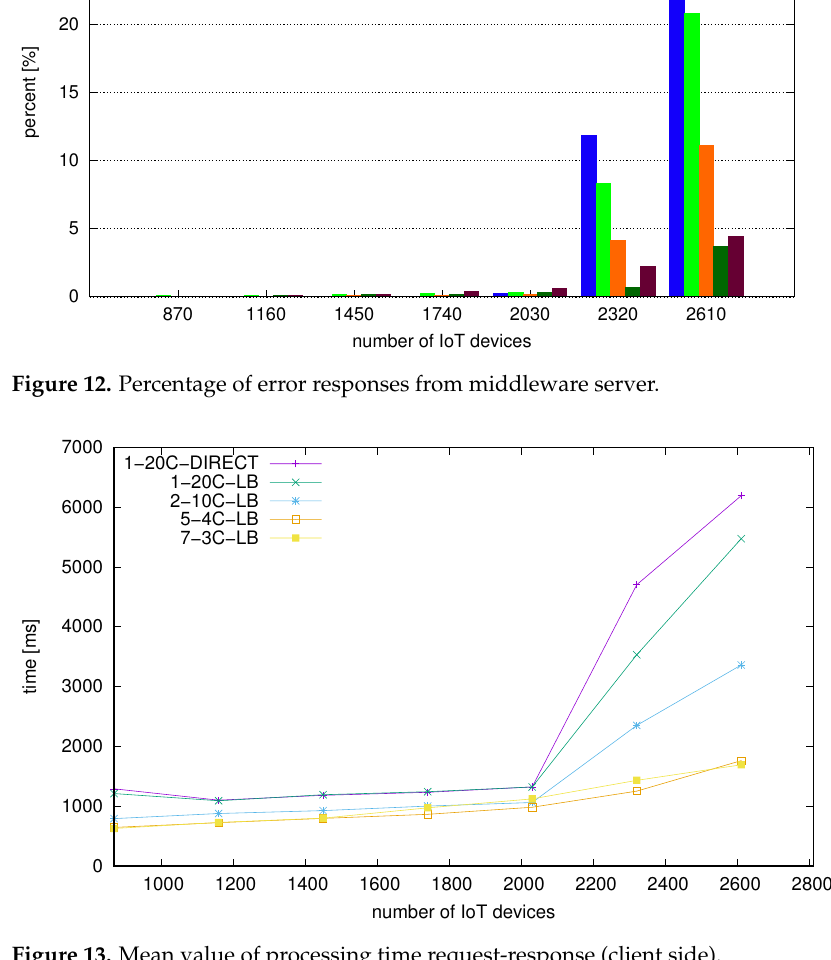
Figure 13. Mean value of processing time request-response (client side).